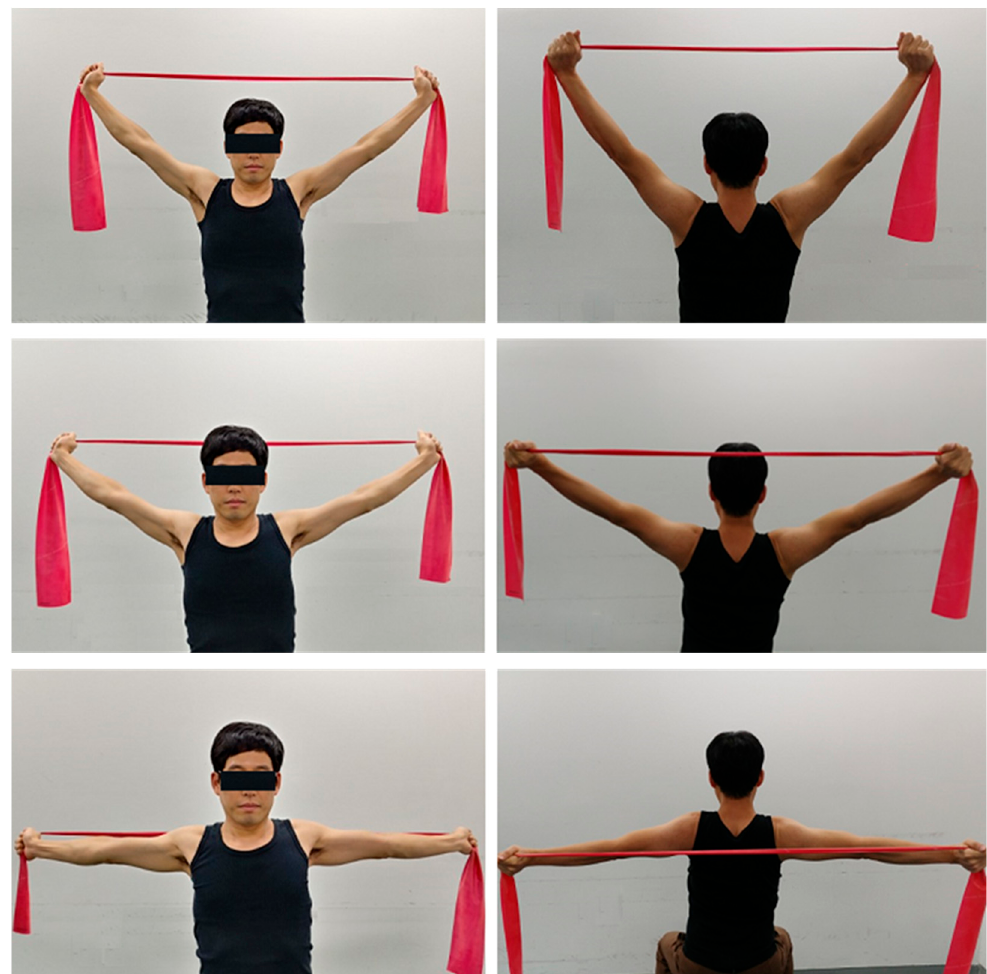
Figure 3. Stretching exercise of pectoralis major and minor.